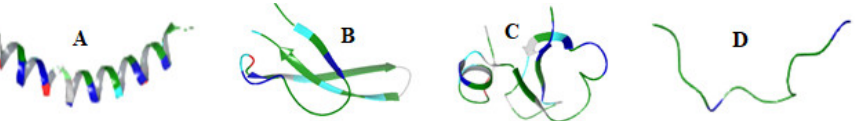
Figure 2. Structural conformations of AMPs. ( A ) α-helical, ( B ) β-sheet, ( C ) αβ-peptides, and ( D ). Non-αβ peptides or extended structure. Images were deciphered by Schrodinger software v2020-3 after structural retrieval from the Protein Data Bank (PDB) at https://www.rcsb.org/ (accessed on 20 May 2021) using the PDB IDs: 2K6O, 1ZMM, 1FD3, and 1G89 for A to D, respectively. AMPs are colored by properties.